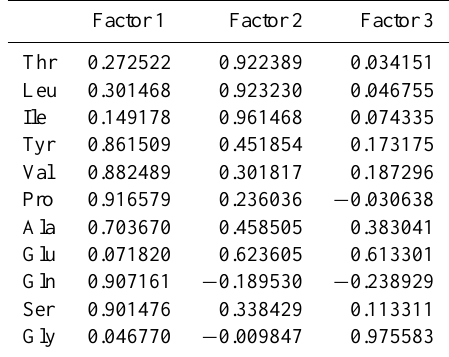
Table 4. Factor loadings matrix after varimax